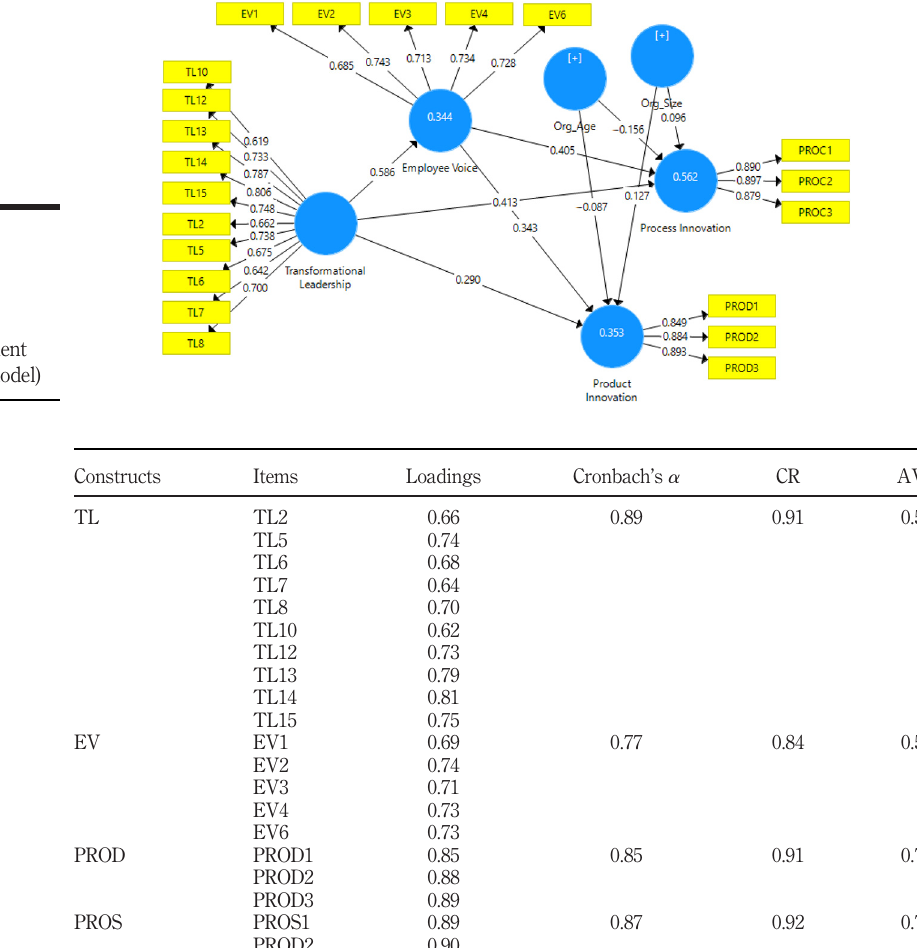
Table 2. Factor loading, reliability and convergent